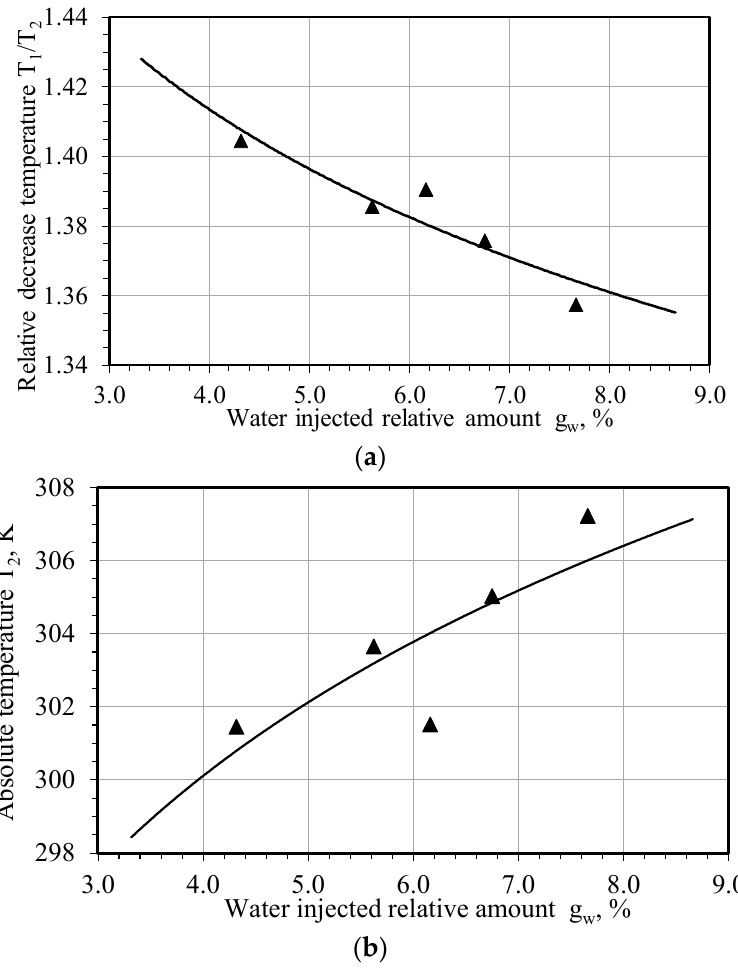
Figure 8. Experimental dependencies of the temperature ratios (T 1 /T 2 ) ( a ) and the temperature T 2 ( b ) on the relative velocity of the evaporation chamber Ma at G w is 0.0175 kg/s.